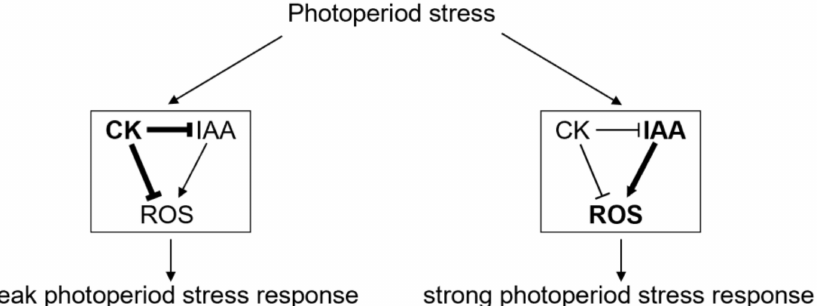
Figure 6. Model of the function and interaction of CK and auxin in the response to photoperiod stress. In leaves showing a weak photoperiod stress response (left side), CK accumulates (bold letters) and inhibits auxin (IAA) and ROS accumulation (thick black arrows). In leaves showing a strong photoperiod stress response (e.g., CK signaling or biosynthesis mutants; right side), CK does not sufficiently repress IAA synthesis or signaling resulting in its accumulation and enhanced signaling (bold letters). IAA ultimately induces ROS formation (bold letters and thick